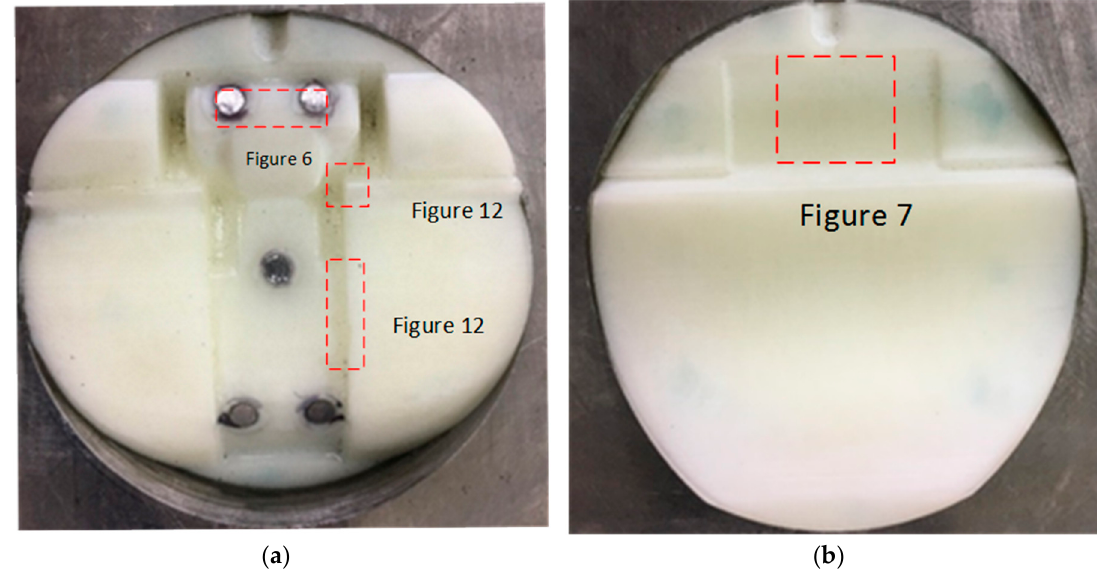
Figure 5. ( a ) Core insert for case study 3, fitted inside a master unit die. ( b ) Cavity insert for case study 3, fitted inside a master unit die. The tool outer diameter is 55 mm.